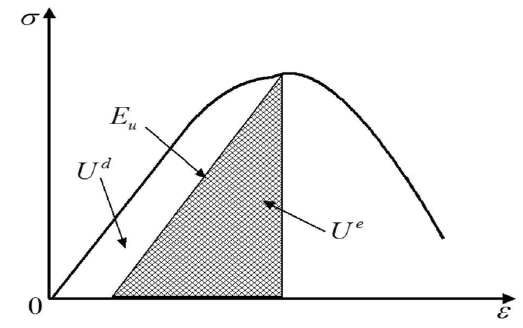
Fig. 13 Relationship between the dissipated strain energy and the elastic strain energy